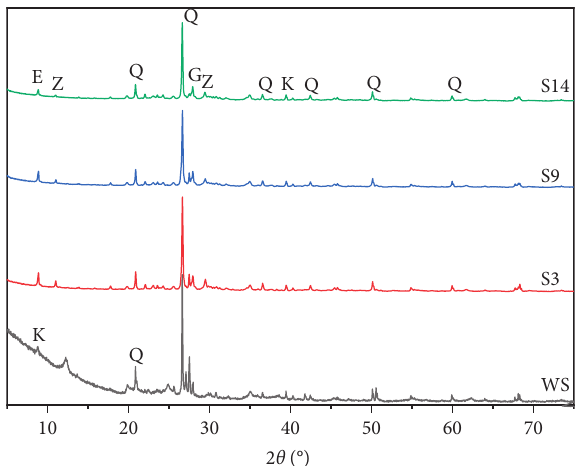
Figure 12: XRD patterns of hardened waste sediment-based grouting material after curing for 28 days: (a) S1; (b) S3; (c) S9; and (d) S14. (q) quartz, (e) ettringite, (z) zeolite, (g) gismondine, (k)